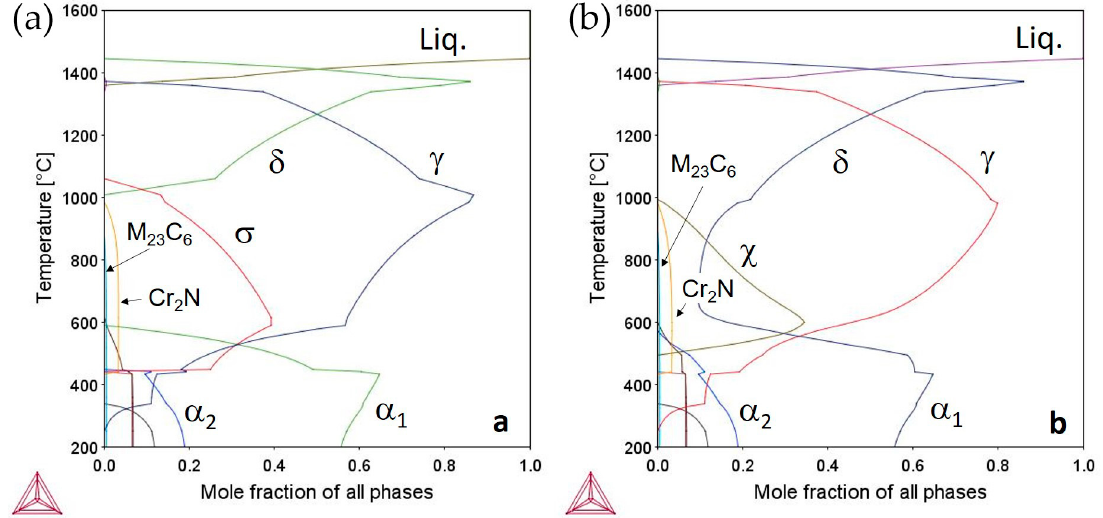
Figure 1. Diagrams showing the mole fraction of phases vs. temperature under equilibrium conditions ( a ) and after suppressing σ -phase formation ( b ).